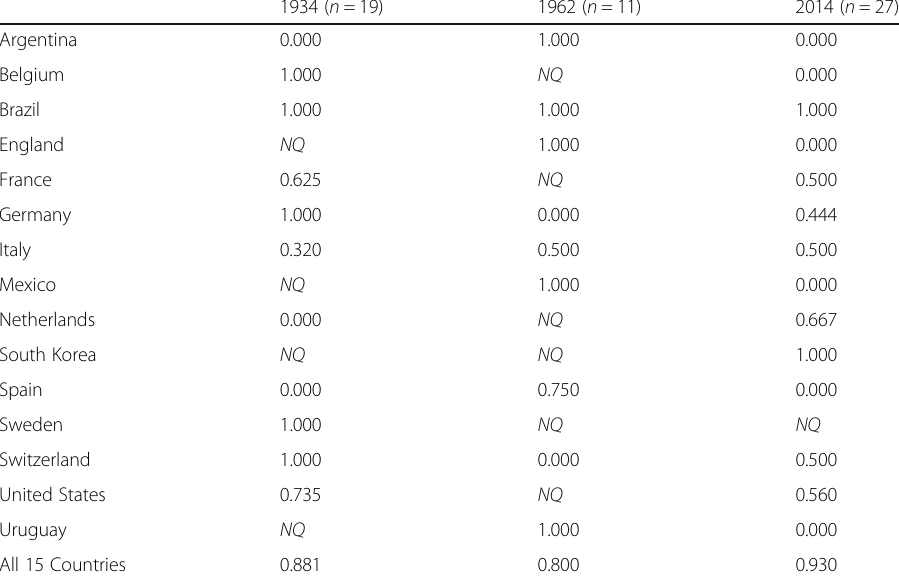
Table 3 Diversity amongst foreign-born football players in the selected national teams 1934 ( n = 19) 1962 ( n = 11) 2014 ( n =